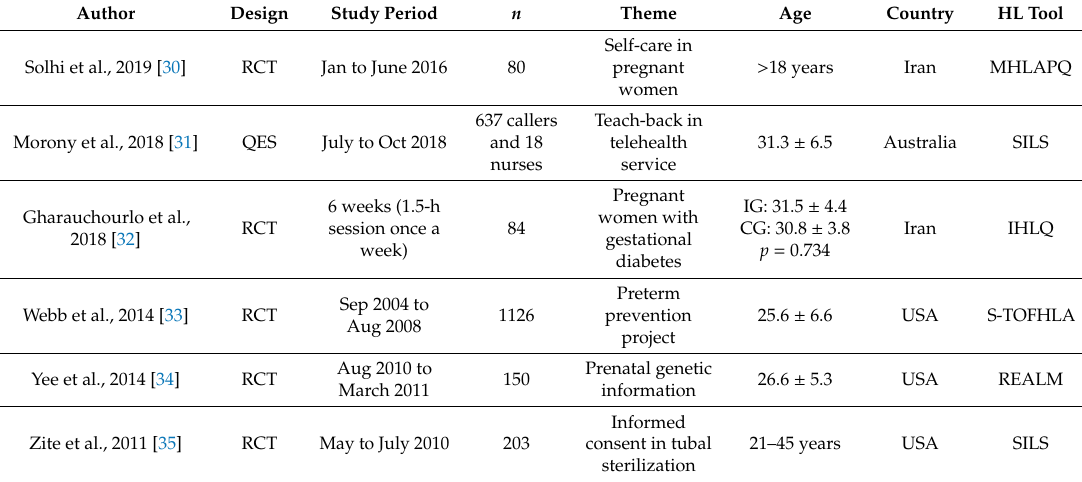
Table 2. Characteristics of the studies included in the